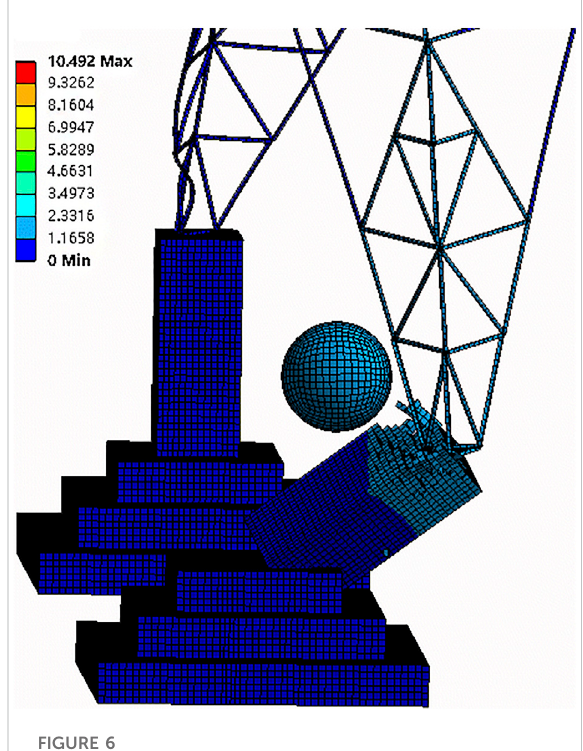
FIGURE 6 Deformation cloud chart under working condition I2.